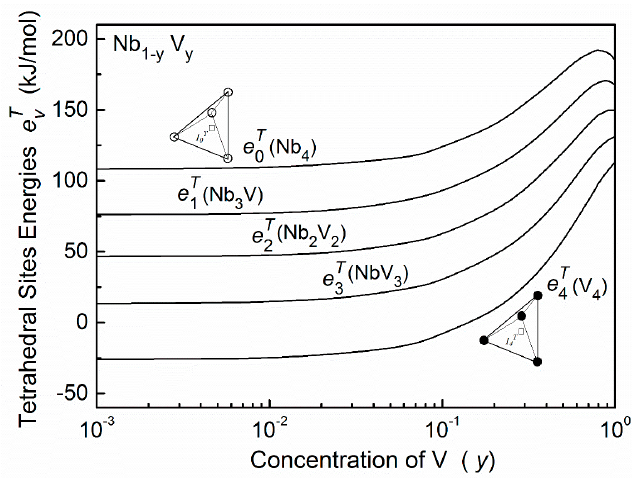
Figure 5. Tetrahedral site energy e T v of oxygen atoms in Nb–V alloys. This energy is also treated as the saddle-point energy for oxygen atoms migrating. ( ○ —Nb atoms, ● —V atoms).